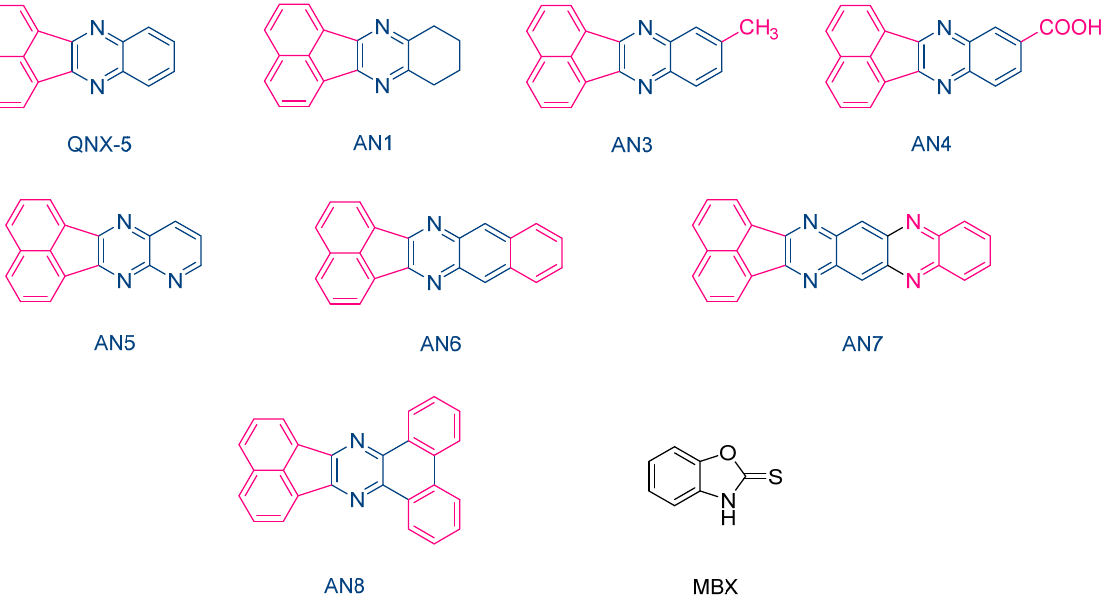
Table 4. Optical characteristics of various acenaphthoquinoxalines in ethanol. Compound